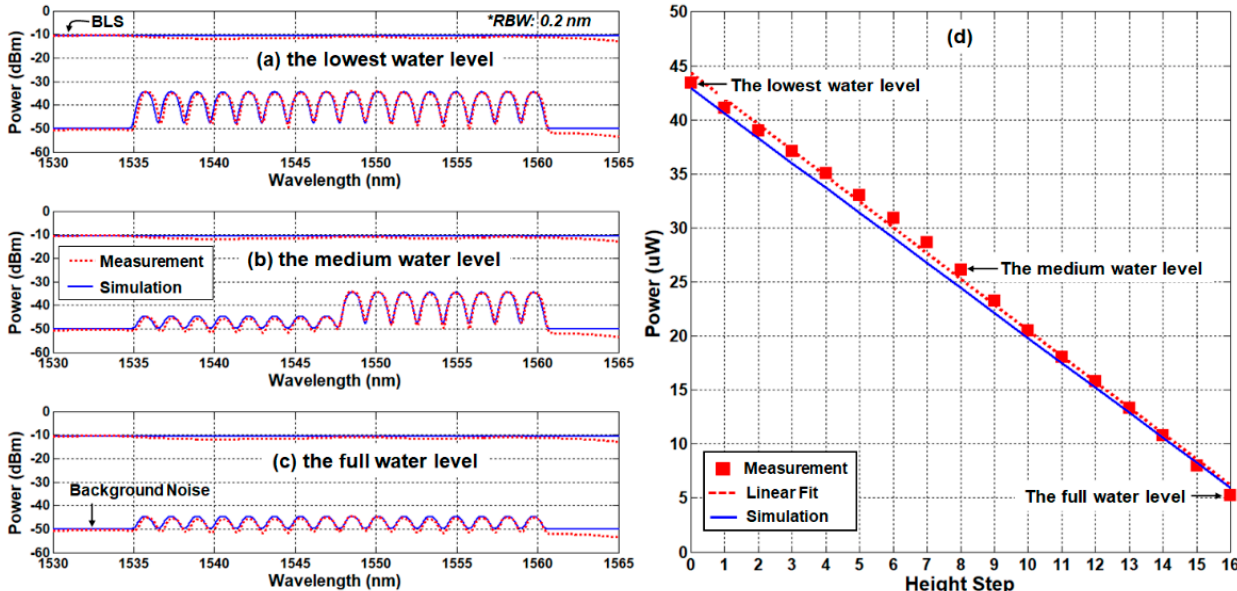
Figure 4. Simulation and measurement results according to the water level in the back-to-back condition: ( a ) the spectra of lowest water level, ( b ) the spectra of 1/2 water level, ( c ) the spectra of full water level, and ( d ) the received optical power as a function of the water level.